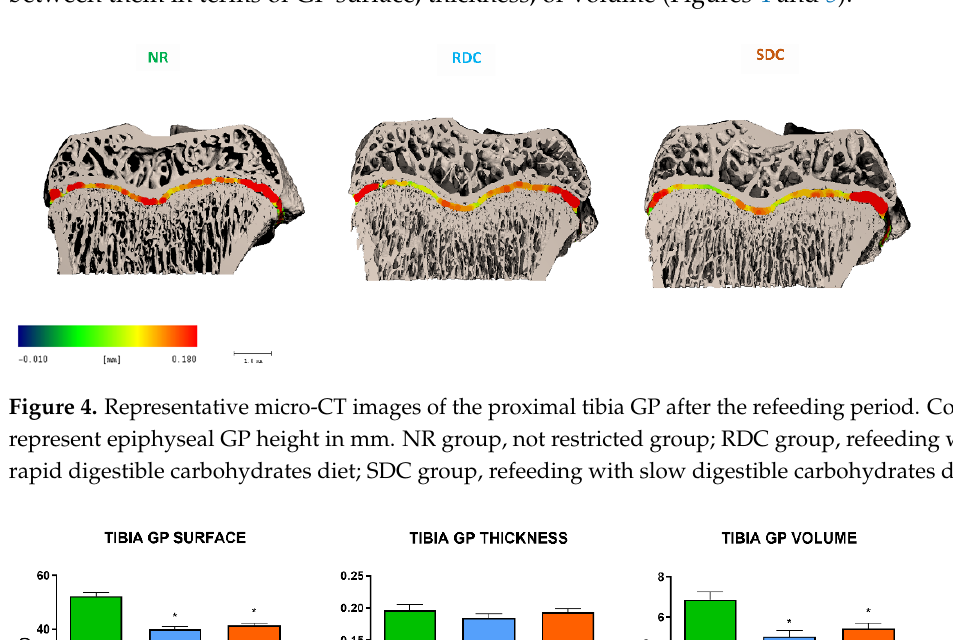
Figure 3. Representative MicroCT images of the vertebra 4 trabecular bone after the refeeding pe- riod. NR group, not restricted group; RDC group, refeeding with rapid digestible carbohydrates diet; SDC group, refeeding with slow digestible carbohydrates diet.